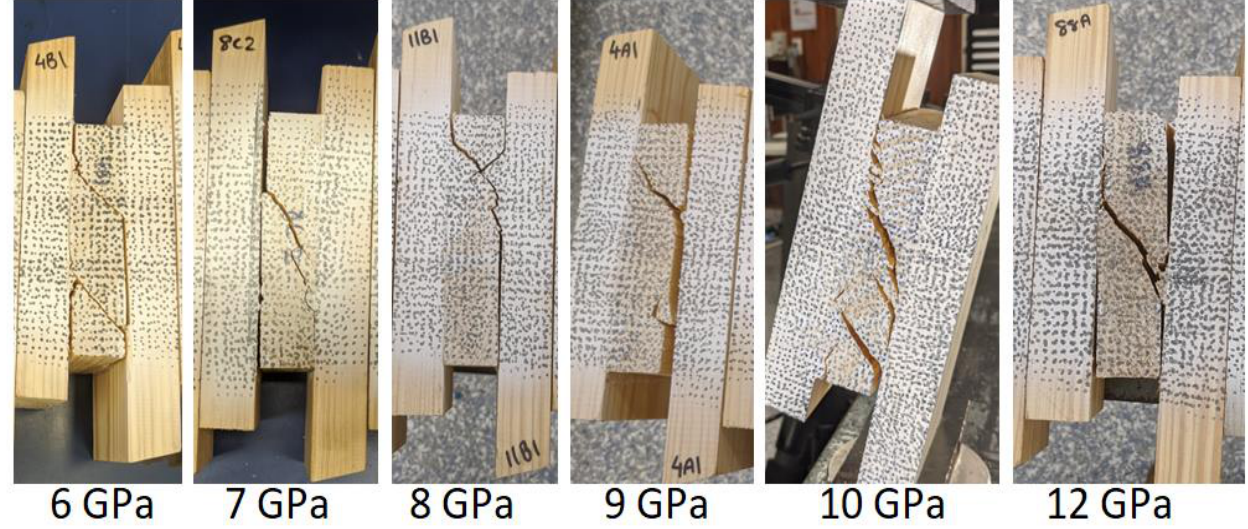
Figure 8. Example of the 6 MOE groupings and their typical failure mode type.